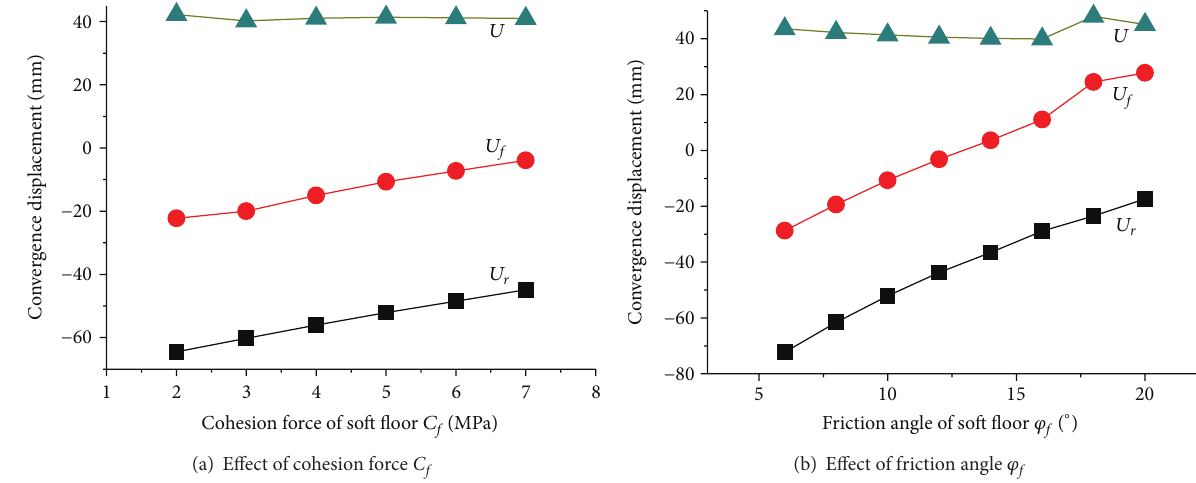
Figure 10: Changes of tunnel displacements with strength parameters of soft floor.